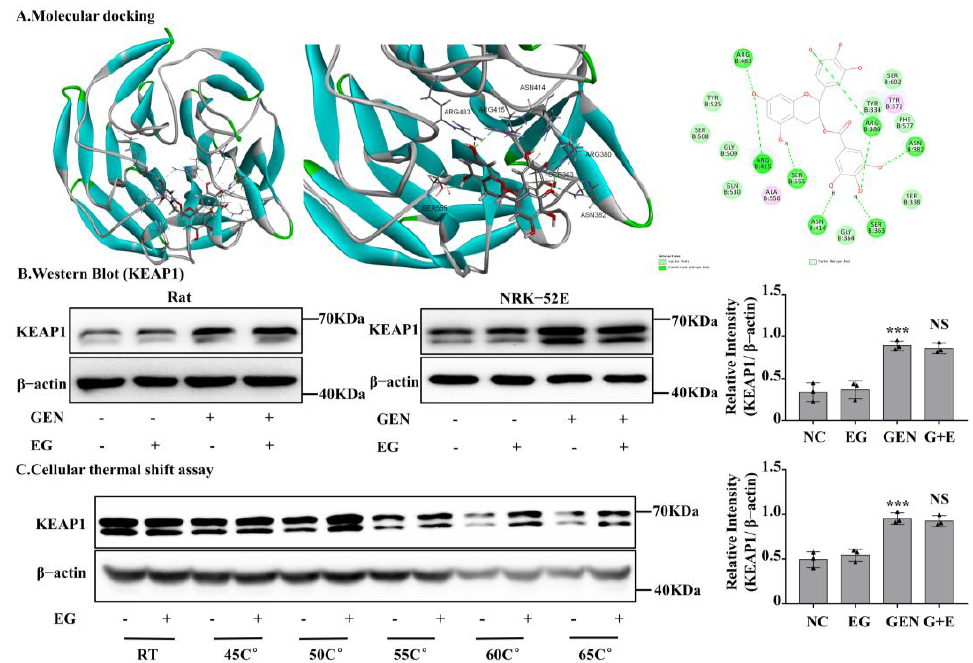
Figure 7. EG stabilized kelch-like ECH-associated protein 1 (KEAP1) in NRK-52E cells and molecular docking analysis. ( A ) Molecular docking model between EG and human KEAP1 protein. EG formed 10 hydrogen bonds with the side chains of R483, R415, S555, N414, S363, R380, and N382. ( B ) The protein level of KEAP1 was analysed by Western blot. ( C ) NRK-52E cells treated with EG (25 μM) for 2 H were collected, put through the freeze–thaw process three times, and heated at the corresponding temperature for 10 min. The Western blot analysed the supernatant protein. In vitro data was expressed as mean ± SEM of three independent experiments. *** p < 0.001 vs. control group; NS vs. GEN group.